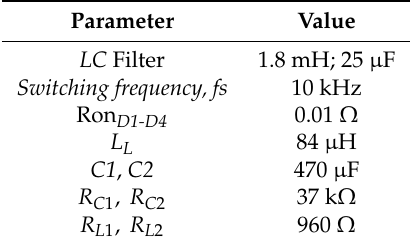
Table 1. Main parameters of VSI and Z NL .